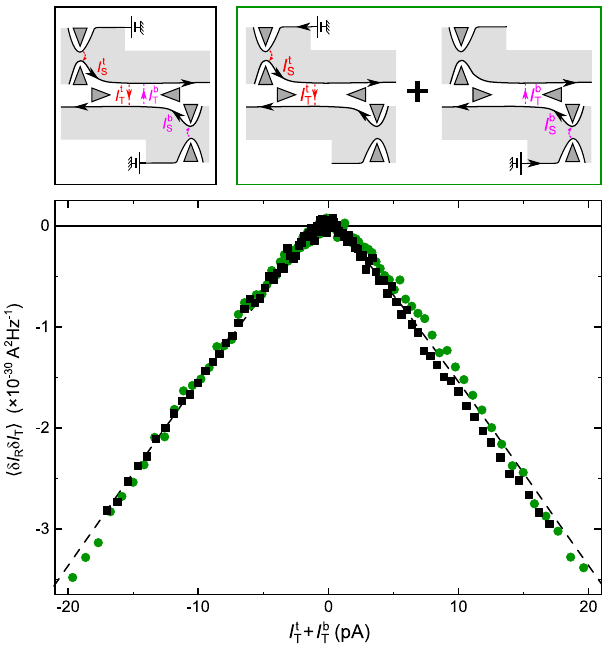
Fig. 4 | Additivity of Andreev cross-correlations from opposite sources. The blacksquaresrepresentthecross-correlationsmeasuredwithtwosimilarbeamsof e /3quasiparticles impinging from opposite sides on the central QPC set in the SBS regime (see top-left schematic). The green circles display the sum of the cross- correlations measured sequentially, using separately the top-right or bottom-right QPC as a single source (see top-right schematic). The dashed line shows the pre- dicted cross-correlations for Andreev scatterings, independent of the symmetry between opposite sources. This contrasts with another, symmetry-dependent mechanism based on the unconventional anyon exchange phase occurring with both source and analyzer in the WBS regime 8,26 .